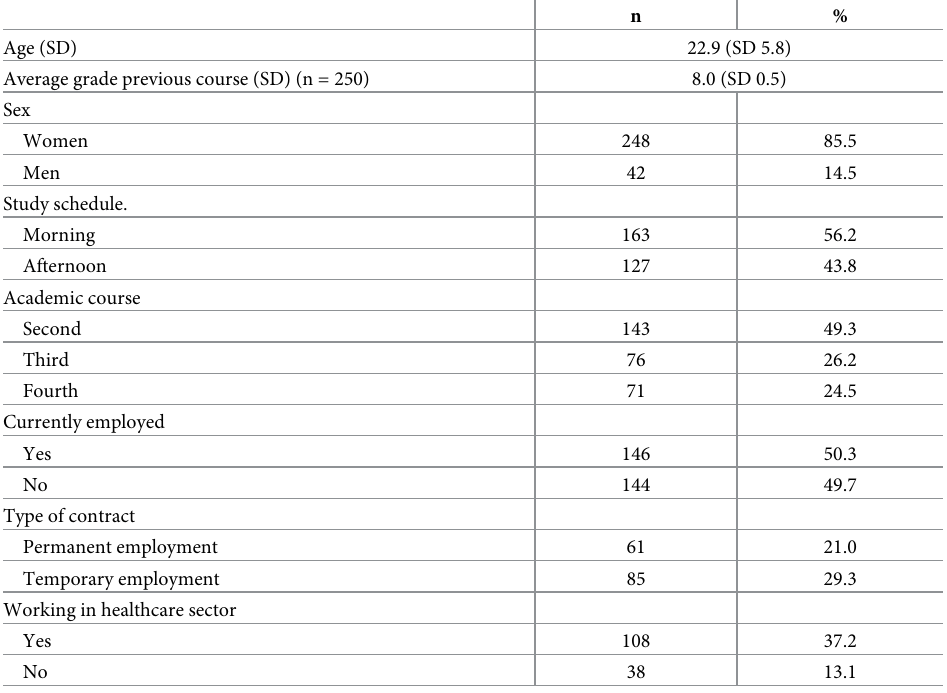
Table 2. Sociodemographic characteristics of the study population (n = 290).